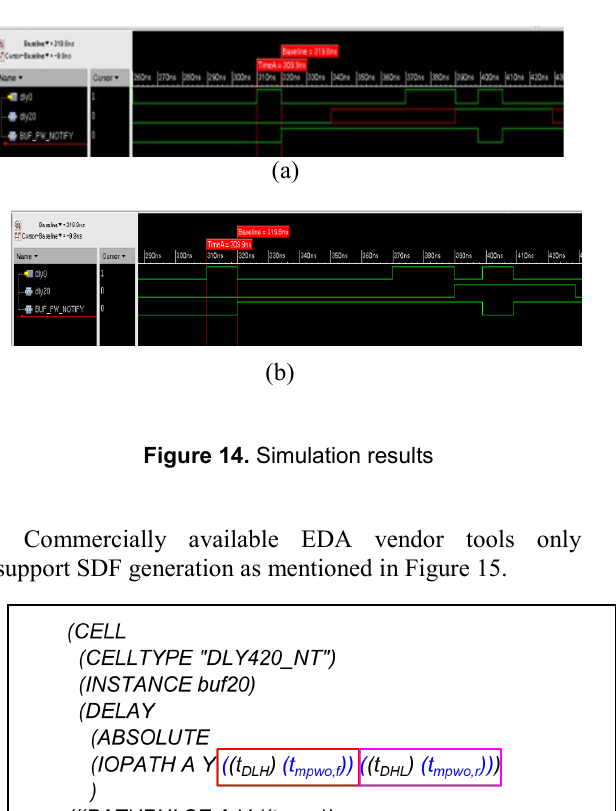
Figure 13. Buffer functional modelling